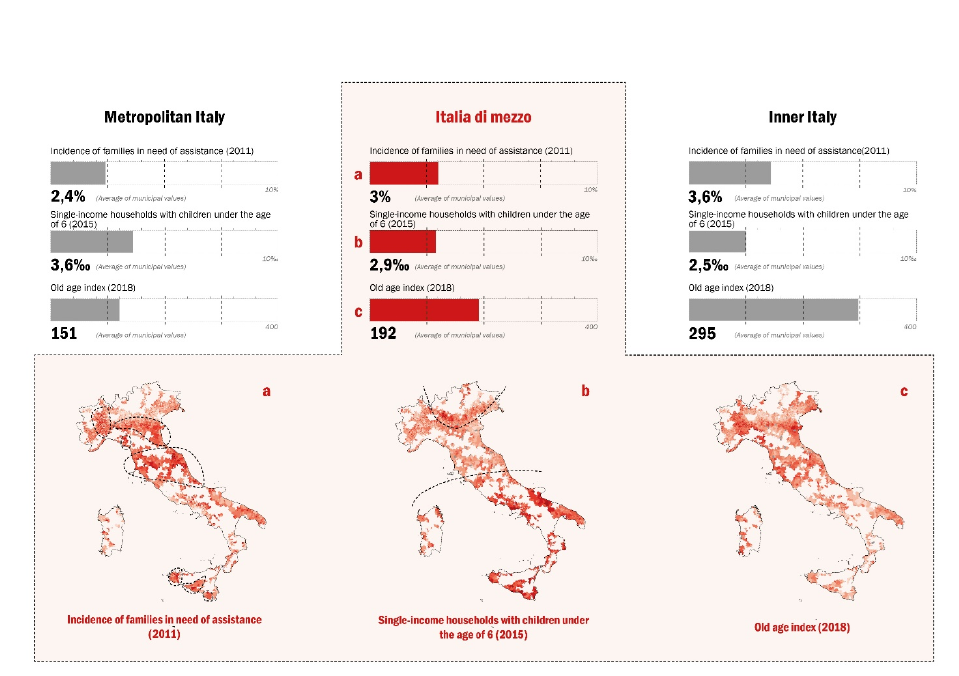
Figure 4: Italia di mezzo “in the middle” for some social hardships Italia di mezzo and the geography of socioeconomic and environmental